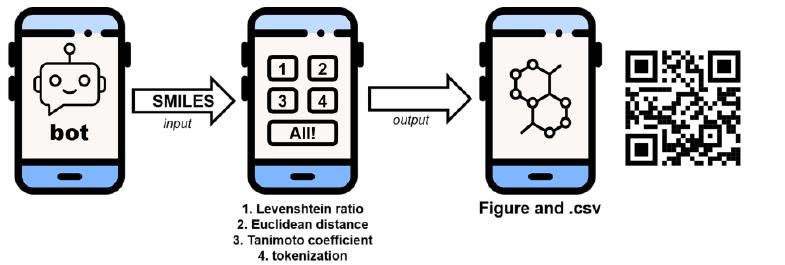
Figure 2. Overview of Telegram bot for the search for molecules sensitive to various cations. The QR code can be used to access the Telegram bot. The user is supposed to enter the SMILES of the molecule of interest and select one of the four methods (Levenshtein ration, Euclidean distance, Tanimoto coefficient, and tokenization/vectorization method) or all methods at once to search for the most similar structures from the database.